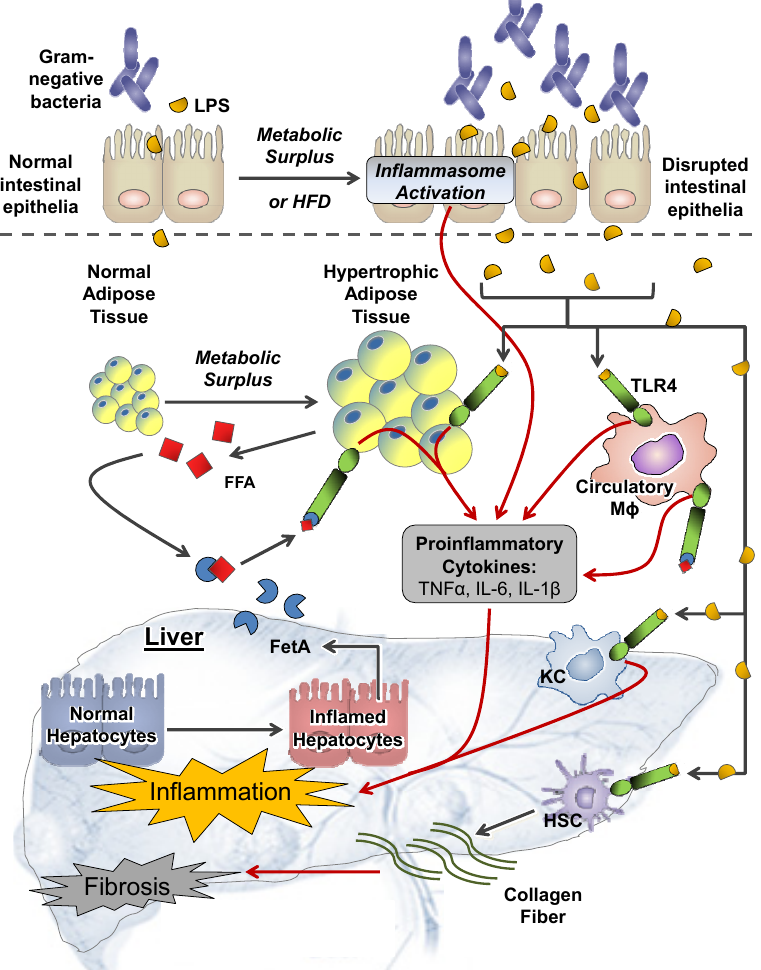
Figure 1. Mechanisms of extra-hepatic perturbations in non-alcoholic fatty liver disease (NAFLD) progression. Metabolic surplus and/or high fat diet (HFD) can disrupt the intestinal epithelia, leading to hepatic inflammation through promoting portal endotoxemia, increasing circulatory lipopolysaccharides (LPS) and activating the inflammasome. Circulatory LPS can stimulate proinflammatory cytokine secretion by macrophages (M ɸ ) and adipocytes through toll-like receptor (TLR)-4-mediated signaling. LPS can also act on Kupffer cells (KCs) and hepatic stellate cells (HSCs) via TLR4 signaling to promote hepatic inflammation and fibrogenesis. Hepatic inflammation activates hepatocytes secrete fetuin A (FetA) into systemic circulation. Metabolic surplus stimulates adipocyte hypertrophy and the subsequent systemic release of free fatty acids (FFA). Circulatory FFA can associate with FetA released from the liver and activate TLR4-mediated proinflammatory signaling in adipocyte and M ɸ , creating a feed-forward mechanism in promoting further systemic and hepatic inflammation. IL: interleukin.